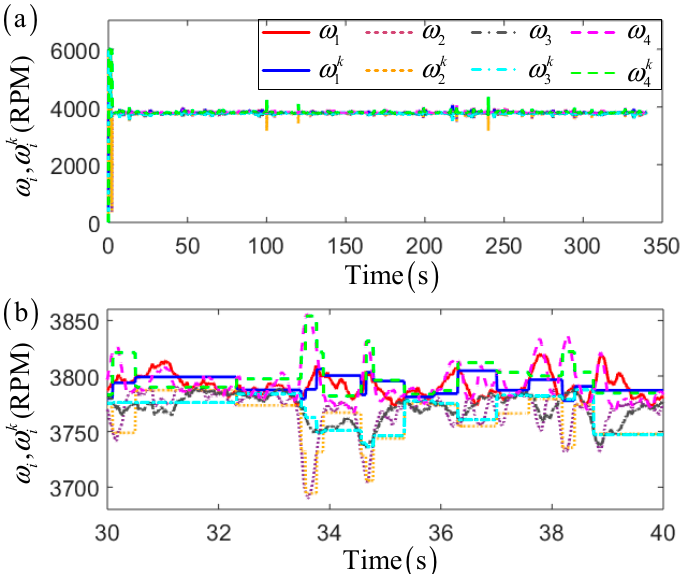
Figure 7. The control input for UAV (( b ) is the partially enlarged detail of ( a )).